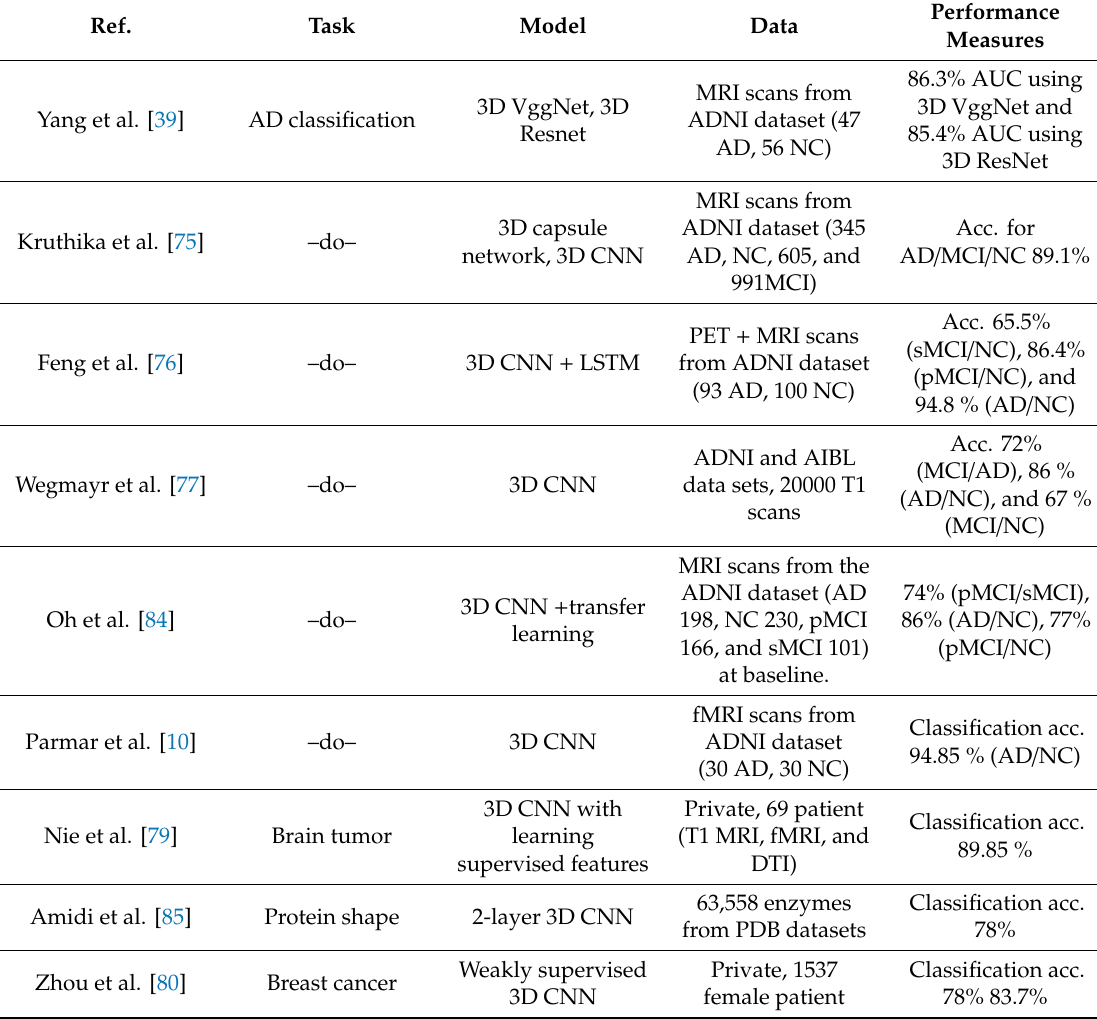
Table 2. 3D CNN for classification tasks in medical